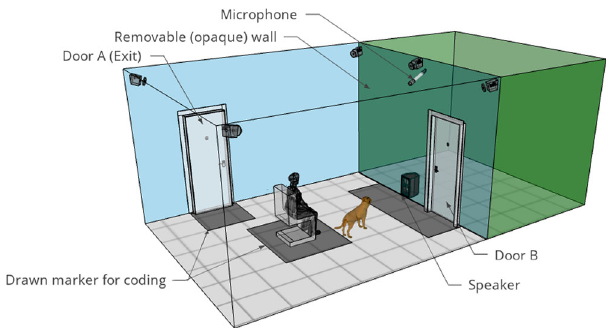
Fig. 3 The setup of the testing room. The owner sat on a chair, listening to music through headphones, and reading a book during the test. The dog moved freely in the room, and the stimulus was played from a speaker hidden behind the opaque, removable wall. Drawn markers served for coding the dogs ’ proximity to the owner, sound source, and exit.